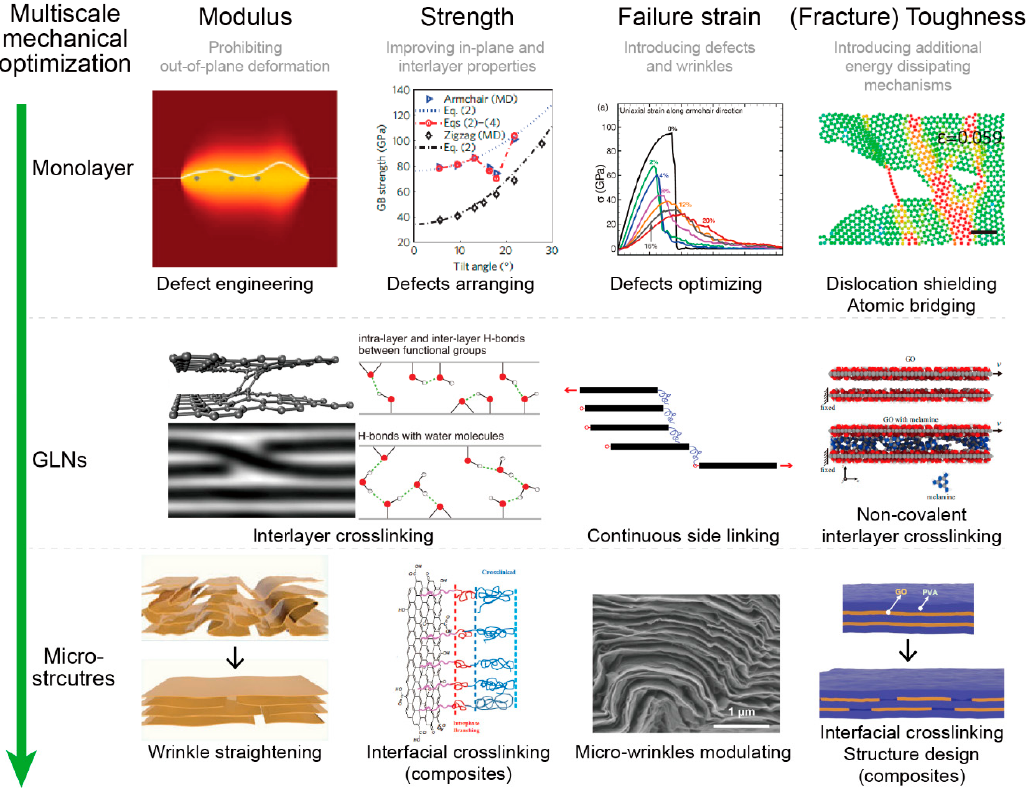
Figure 17. Multi-scale optimization of GLMs. Reprinted with permission from